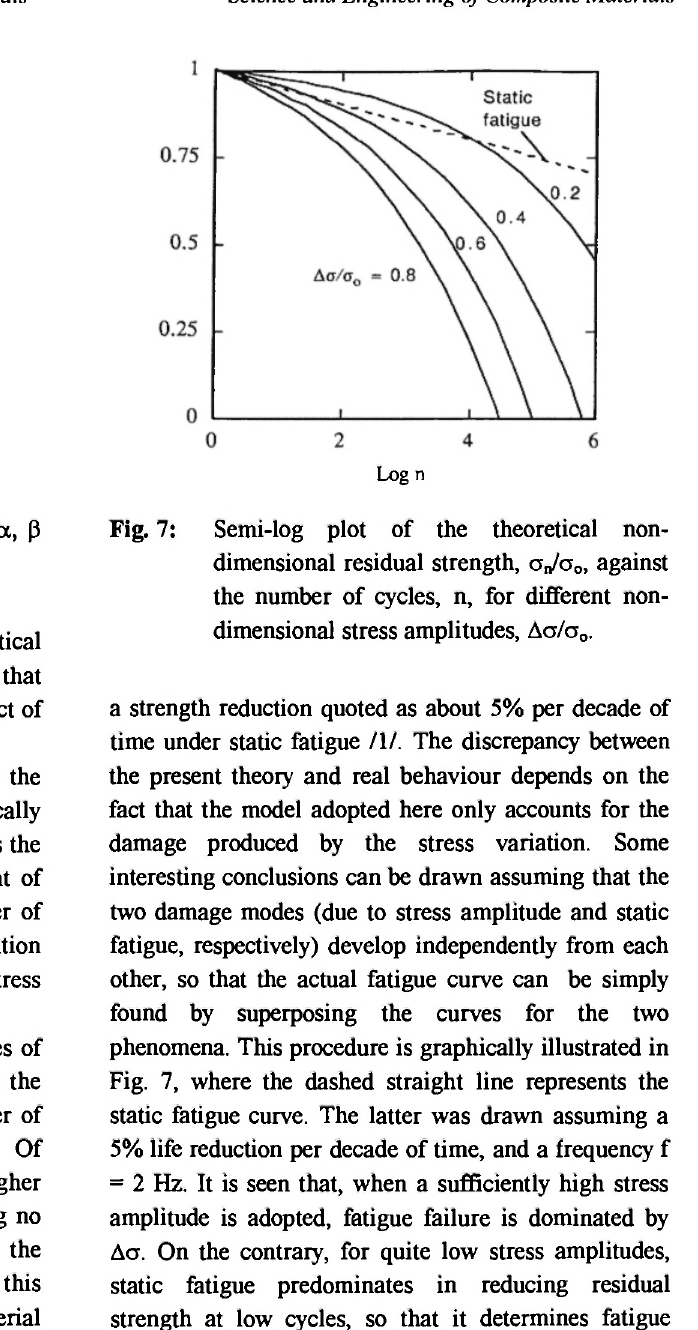
Fig. 6: Plot for the evaluation of the constants α, β appearing in eq. (9).